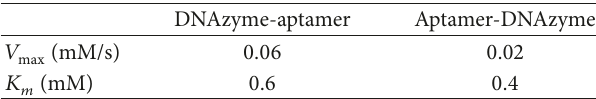
Table 2: Kinetic parameters for DNAzyme-aptamer and aptamer- DNAzyme catalytic